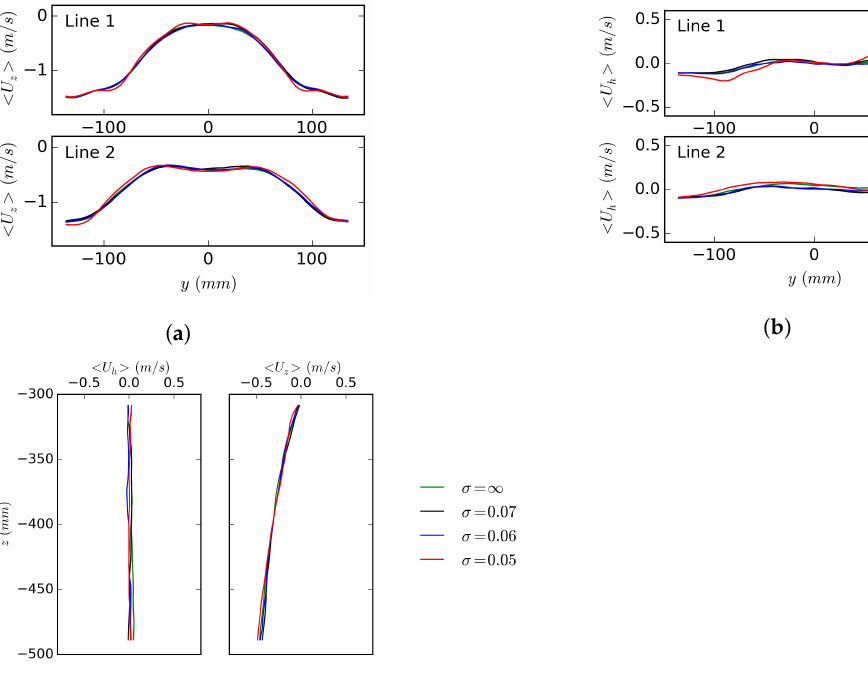
Figure 13. Comparison between the time-averaged velocities over the lines in Figure 2 for different cavitation numbers. ( a ) Averaged axial velocity over Lines 1 and 2. ( b ) Averaged horizontal velocity over Lines 1 an 2. ( c ) Averaged horizontal (left) and axial (right) velocities over Line